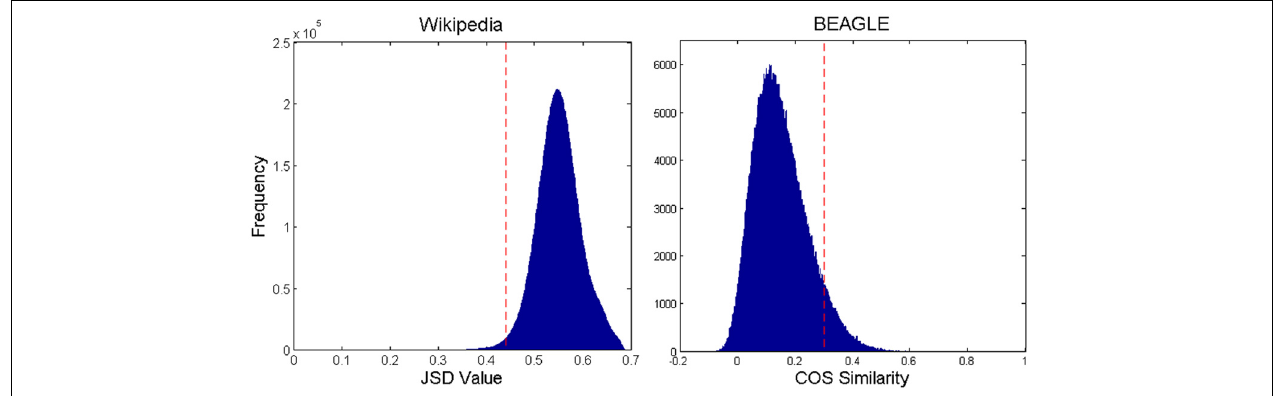
FIGURE 1 | Histogram of all pairwise JSD values for Wikipedia and BEAGLE animal pages, with the network connection threshold shown by the dashed vertical line. For Wikipedia, smaller values mean greater similarity. For BEAGLE, it is the reverse.